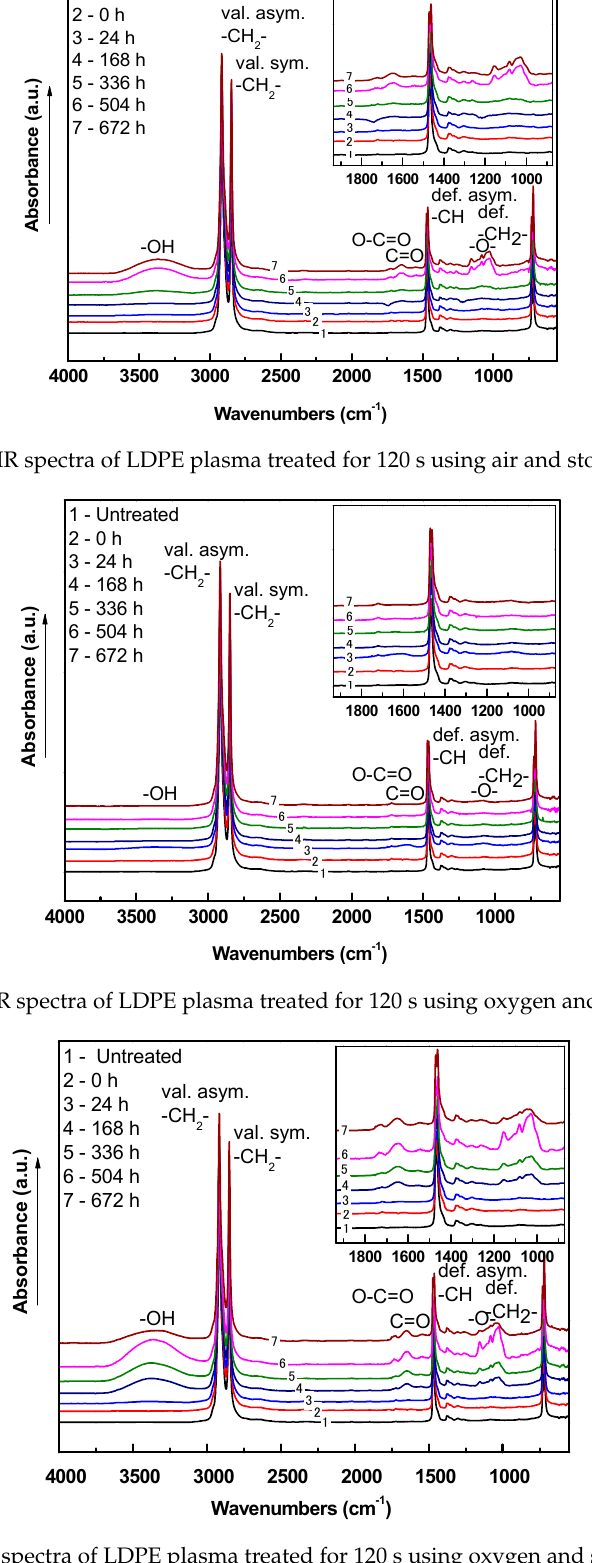
Figure 15. FTIR spectra of LDPE plasma treated for 120 s using oxygen and stored in water.